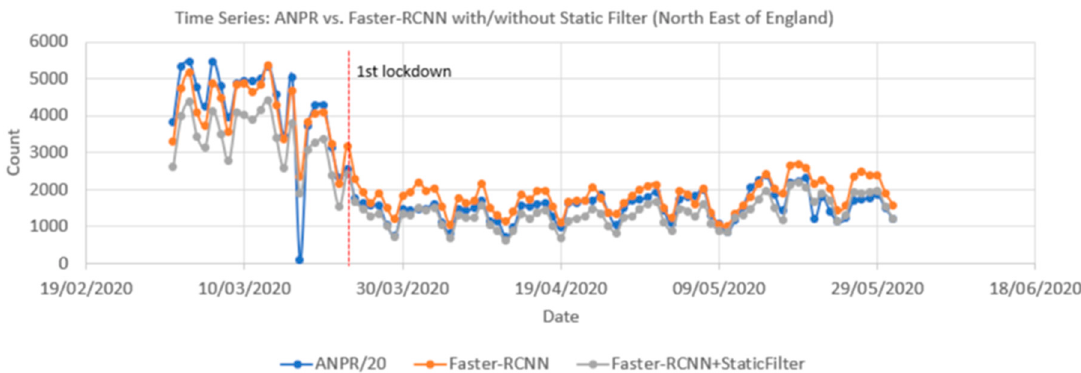
Figure 16. Comparison of traffic count time series produced from Automatic Number Plate Recognition (ANPR) and object detection using open traffic cameras (with and without a filter for static objects) for the same locations between 1 March